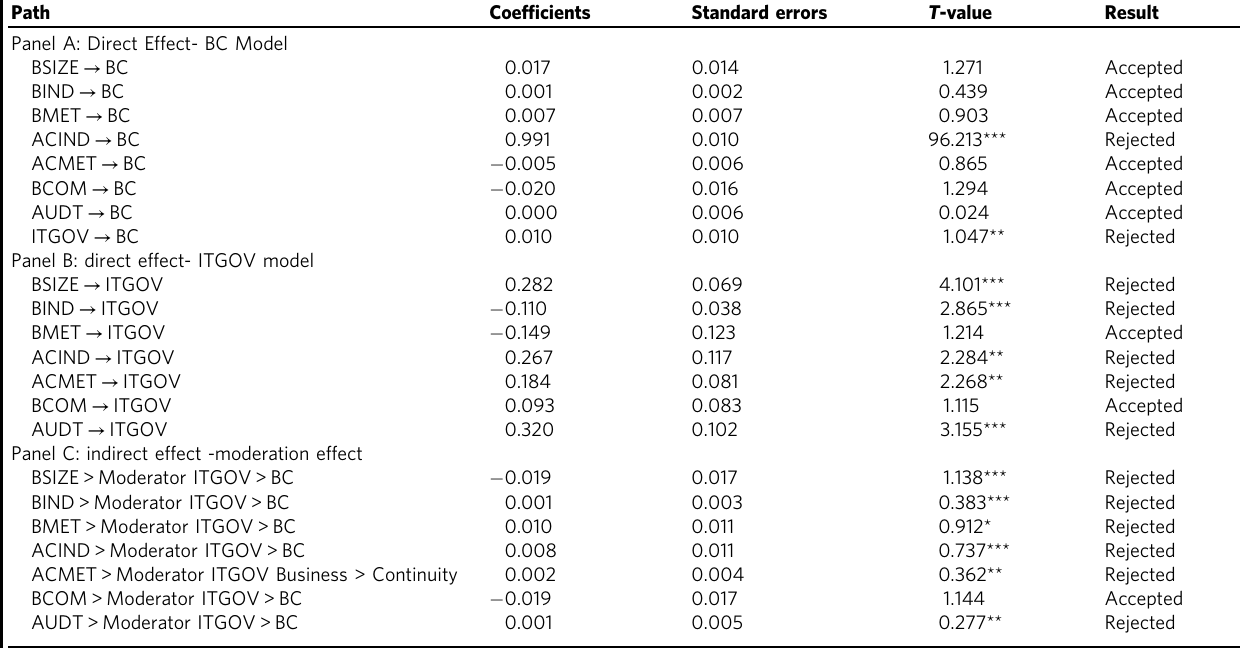
Table 8 The moderating role of ITG. Path Panel A: Direct Effect- BC Model BSIZE →